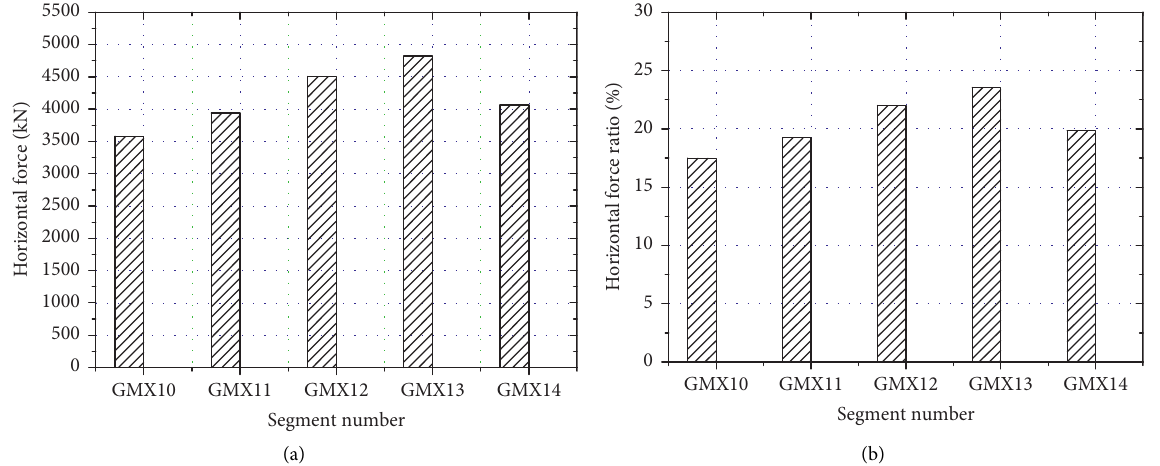
Figure 6: Horizontal force and its ratio borne by the side plate of each segment. (a) Horizontal force. (b) Horizontal force ratio.